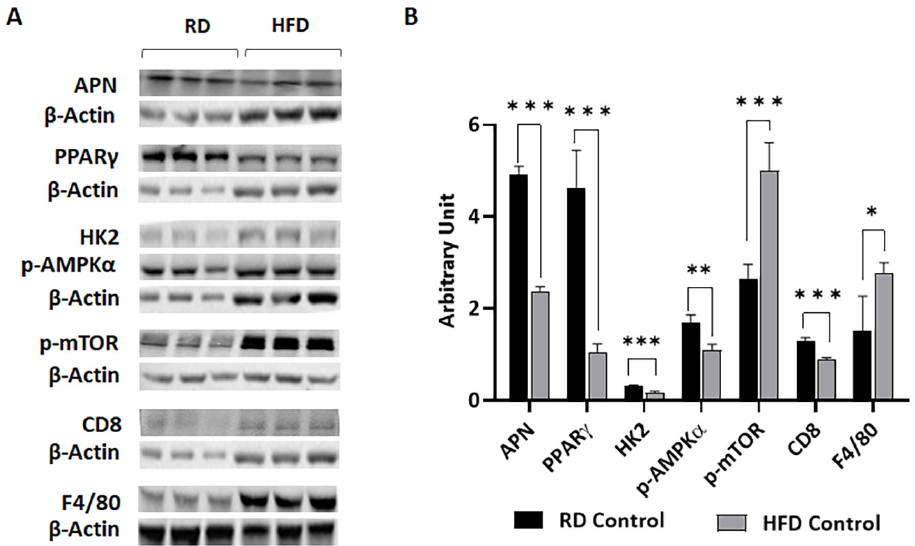
Figure 2. Short-term HFD consumption decreased the expression levels of adiponectin (APN), PPAR γ , hexokinase II (HK2), p-AMPK α , and CD8 and increased the levels of p-mTOR and F4/80 in the mammary fat pads of healthy female C57BL/6J mice compared to mice fed on a carbohydrate-rich RD. ( A ) Immunoblots showing different protein expression between RD- and HFD-fed healthy mice. β -Actin was used as loading control. ( B ) Bar graphs showing the levels of each protein marker normalized to β -Actin. The error bars represent the standard error of the mean. * p ≤ 0.05, ** p < 0.005, and *** p ≤